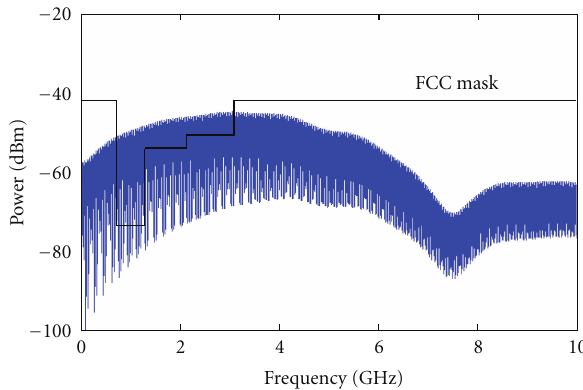
Figure 9: Power spectrum of monocycles generated with VCC1 = 3.3V, VCC2 = 6V, VCC3 = 13 V, and PRF = 3MHz.